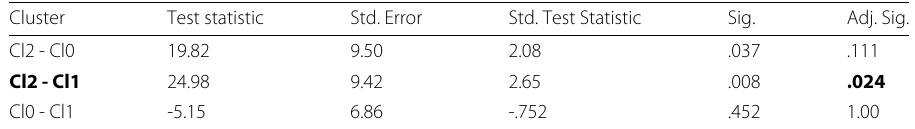
Table 5 Pairwise comparison test results among clusters (an Adj. Sig. value < 0.05 indicates significant difference between the analyzed groups) Cluster Test statistic Std. Error Std. Test Statistic